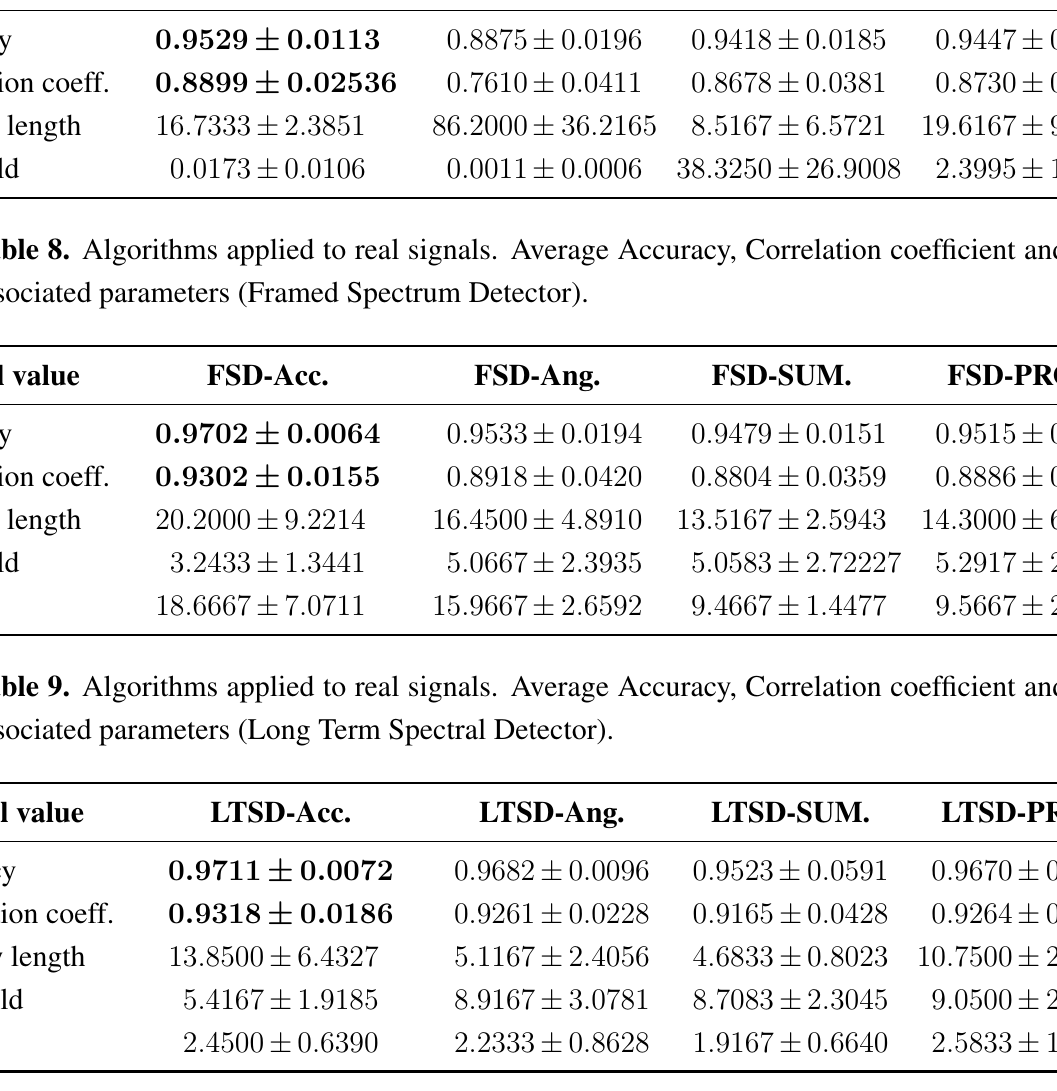
Table 10. Algorithms applied to real signals. Average Accuracy, Correlation coefficient and associated parameters (Memory Based Graph Theoretic